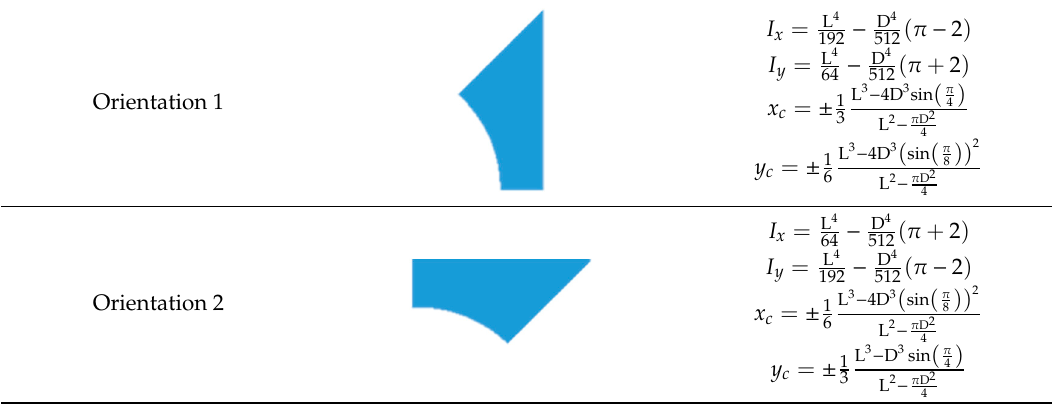
Figure 26. Simplified model showing tank walls and sea water: ( a ) planar view and ( b ) typical compartment. Table 5. Second moment of area and center of gravity of sea water compartment.